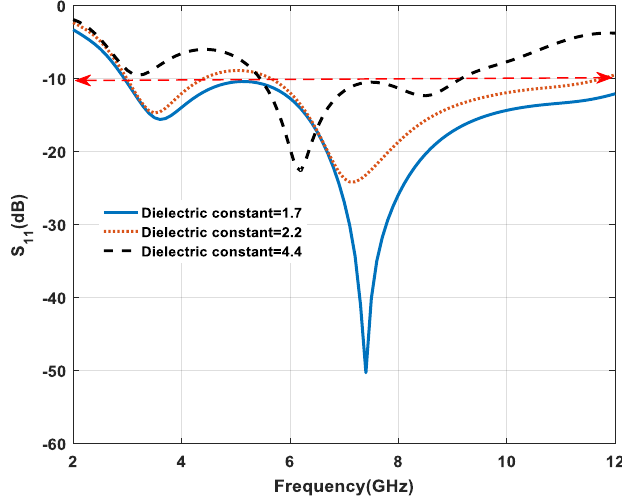
Figure 5. E ff ect of variation on dielectric Figure 5. Effect of variation on dielectric constant. Figure 5. Effect of variation on dielectric constant.